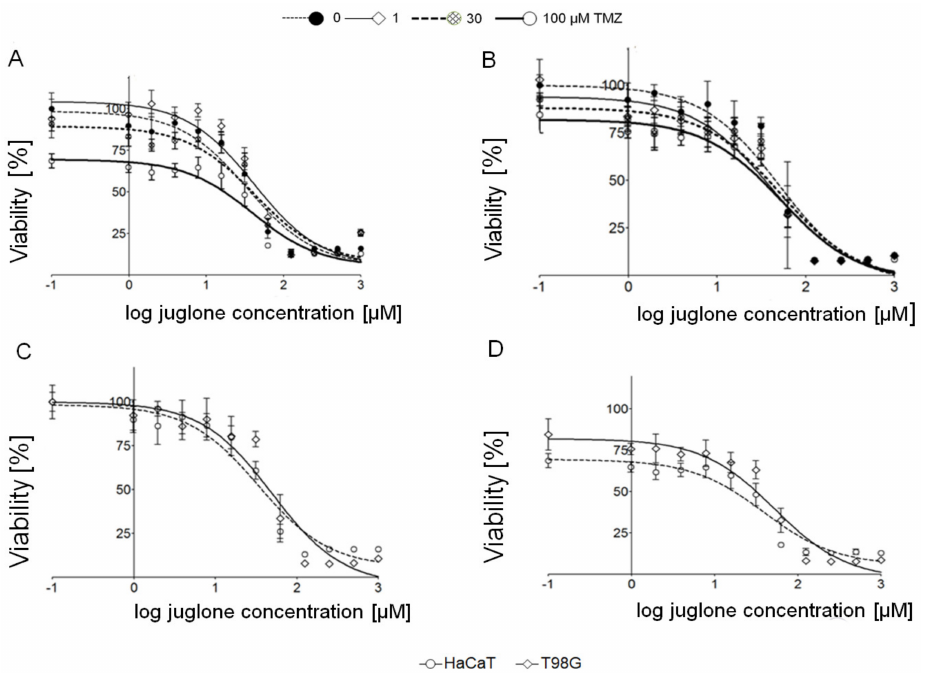
Figure 4. Juglone effect on ( A ) human keratinocyte (HaCaT) and ( B ) glioblastoma (T98G) cell lines alone and with TMZ. Cells proliferation was analyzed 24 h after supplementation with juglone (1–1000 µ M, − 1 to 3 in logarithmic scale) and TMZ (0, 1, 30, 100 µ M). ( C ) Juglone concentration 1–1000 µ M ( − 1 to 3 in logarithmic scale) without TMZ and ( D ) with 100 µ M